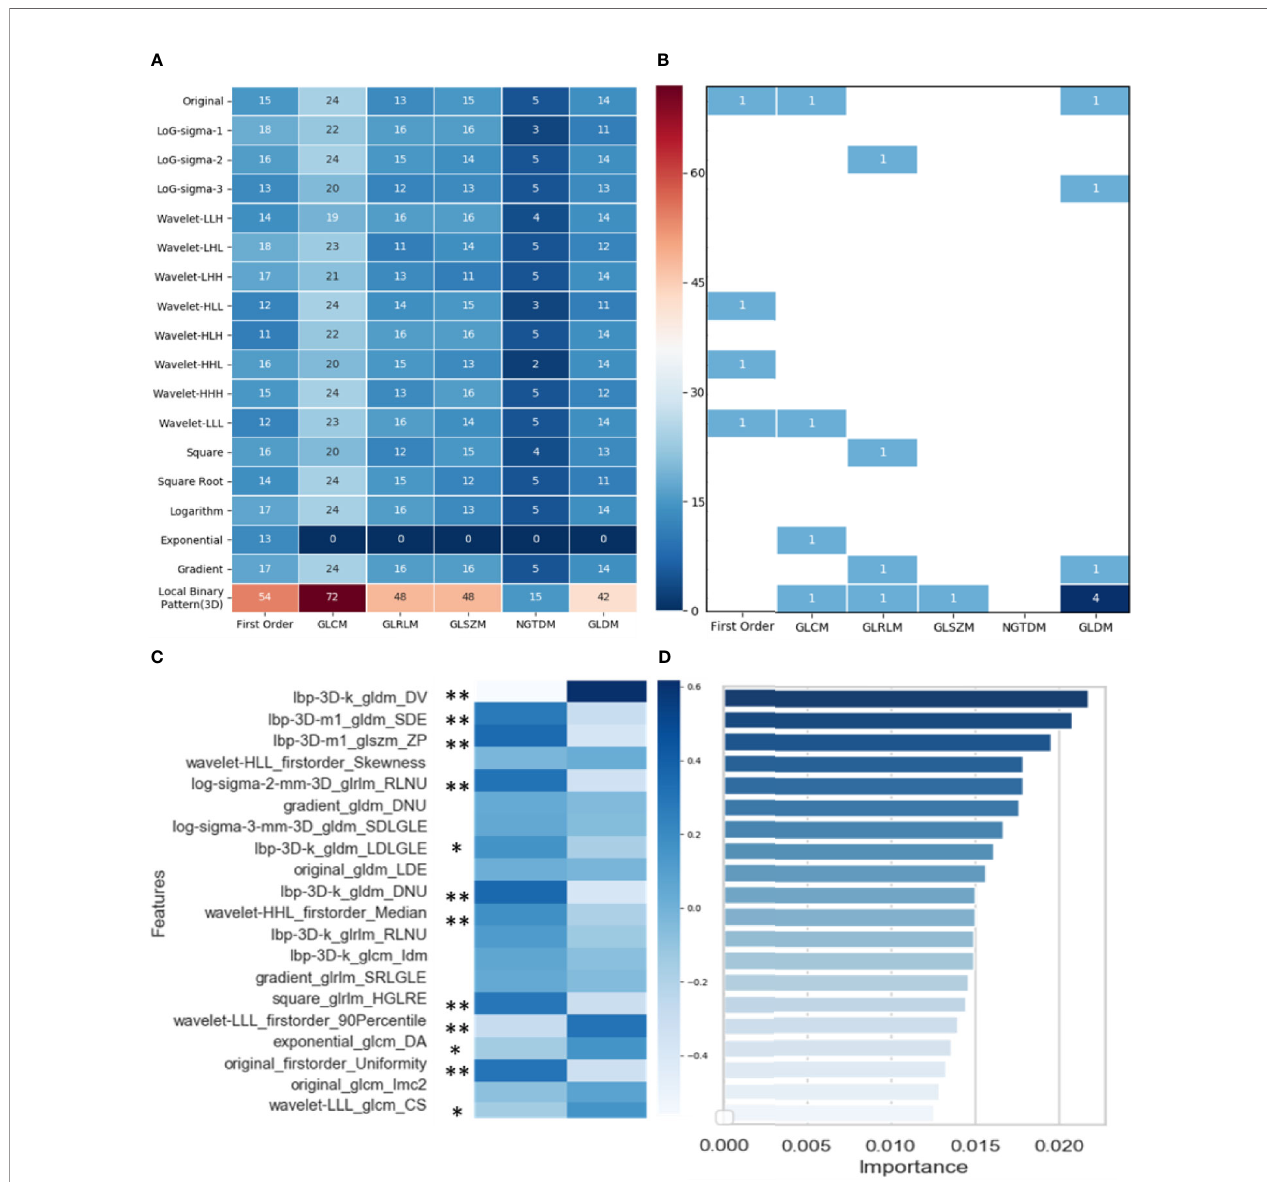
FIGURE 4 | Analysis and selection of radiomic features: (A) Distribution of 1629 extracted features; (B) Distribution of 20 selected features; (C) Mean values of 20 highly informative features and signi fi cance analysis between two groups (* p < 0.05, ** p < 0.001); (D) Importance of 20 selected